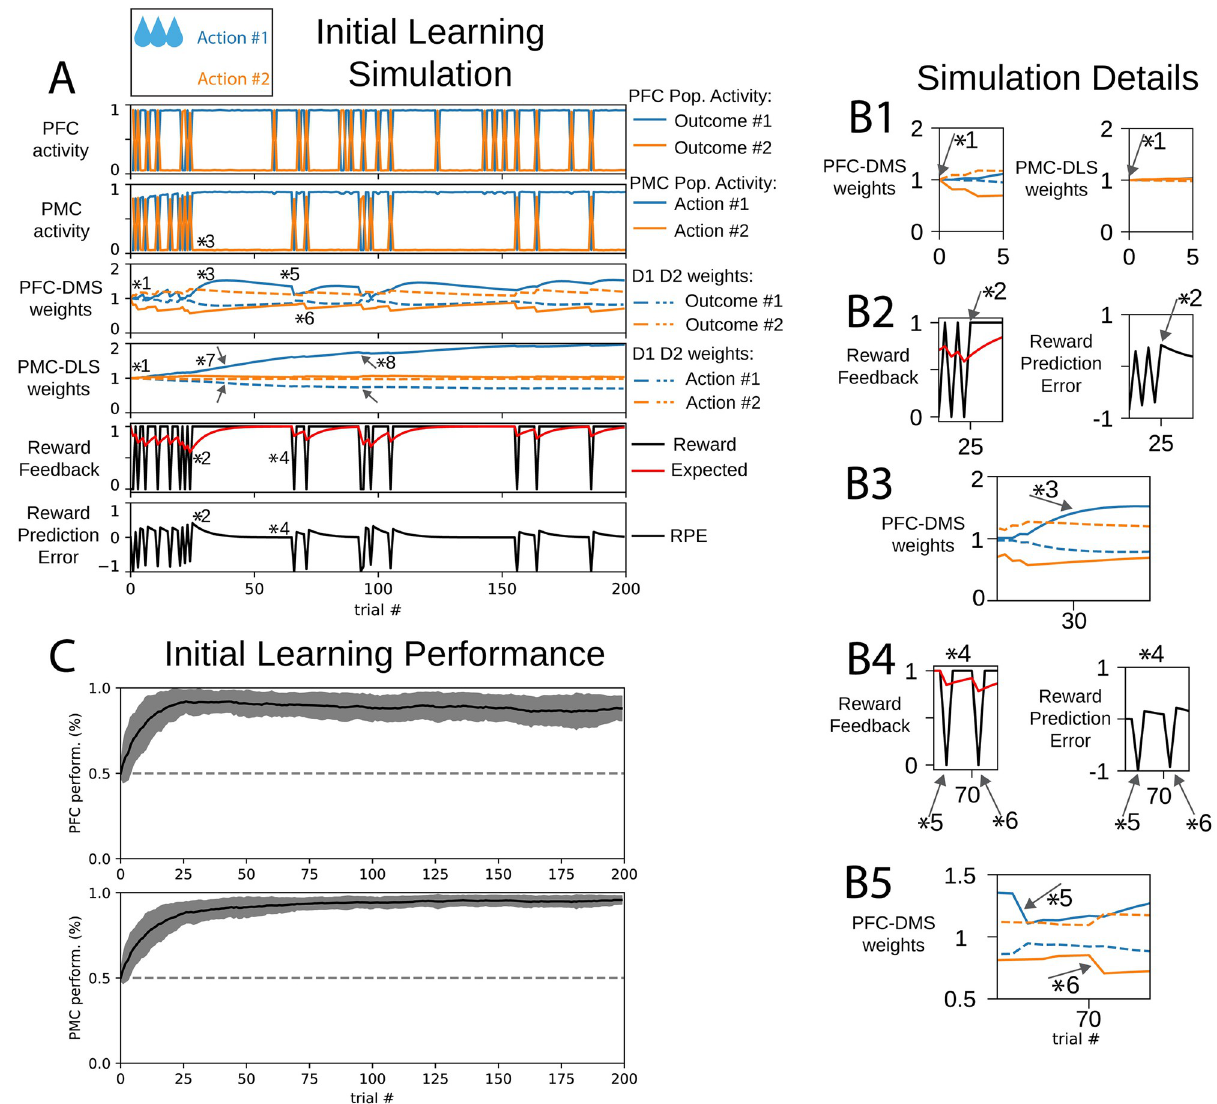
Fig 3. An agent learns to select action #1 in a initial learning behavioral task. (A) Cortical activity, cortico-striatal synaptic weights, and reward feedback metrics during initial learning behavioral session. In panels depicting cortico-striatal weights, D1 synaptic weights are solid traces and D2 synaptic weights are dashed traces. Blue traces correspond to action #1 and orange traces correspond to action #2. (B) Insets correspond to trials indicated by markers 1–6 in part (A). (B1) Initial D1, D2 weights were not biased to select either action. (B2) When the reward was greater than the expected reward, the reward prediction error (RPE) was positive. (B3) The PFC-DMS cortico-striatal synaptic weights evolve to promote the selection of outcome #1. (B4) When the expected reward is high and no reward is delivered, the reward prediction error becomes negative. (B5) Marker � 5: selection of outcome #1 is de-emphasized when PFC selects outcome #1 and PMC selects the unrewarded action #2. Marker � 6: selection of outcome #2 is de-emphasized when PFC selects outcome #2 and PMC selects the unrewarded action #2. (C) Learning performance of 100 agents. Performance is defined as the likelihood for an agent to selection action